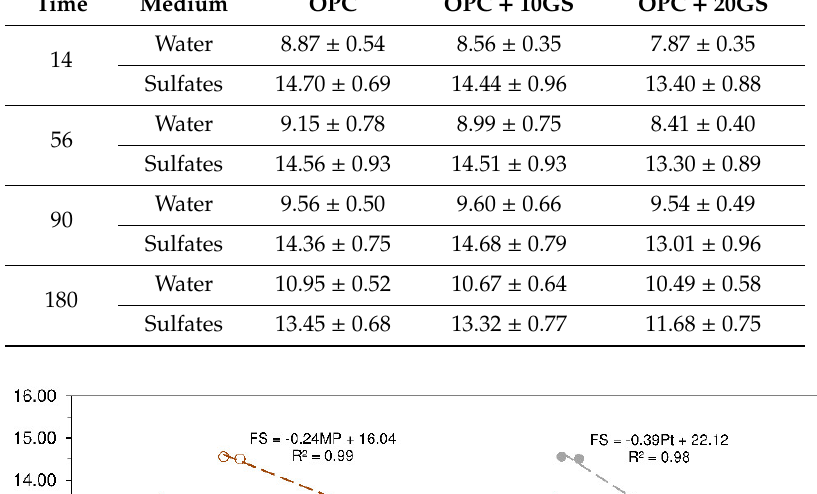
Table 2. Flexural strength (MPa) in cement pastes exposed to water and sulfates.